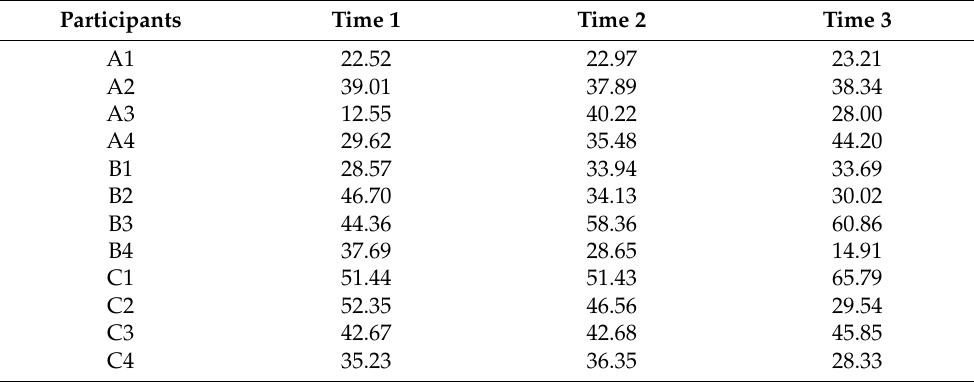
Table 3. Diurnal variations and effect of smoking on urine indole levels.